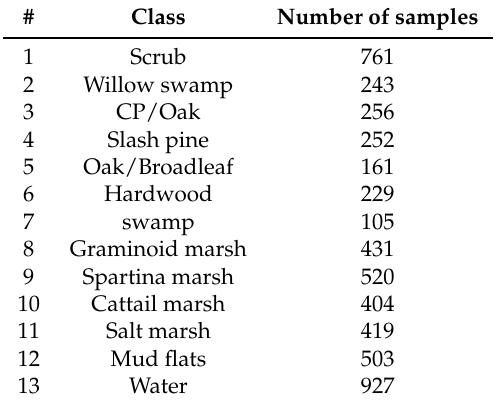
classification. 13 different land cover classes available in the original dataset are displayed in Table 2. Table 2. Groundtruth classes of the KSC scene and their respective samples number.